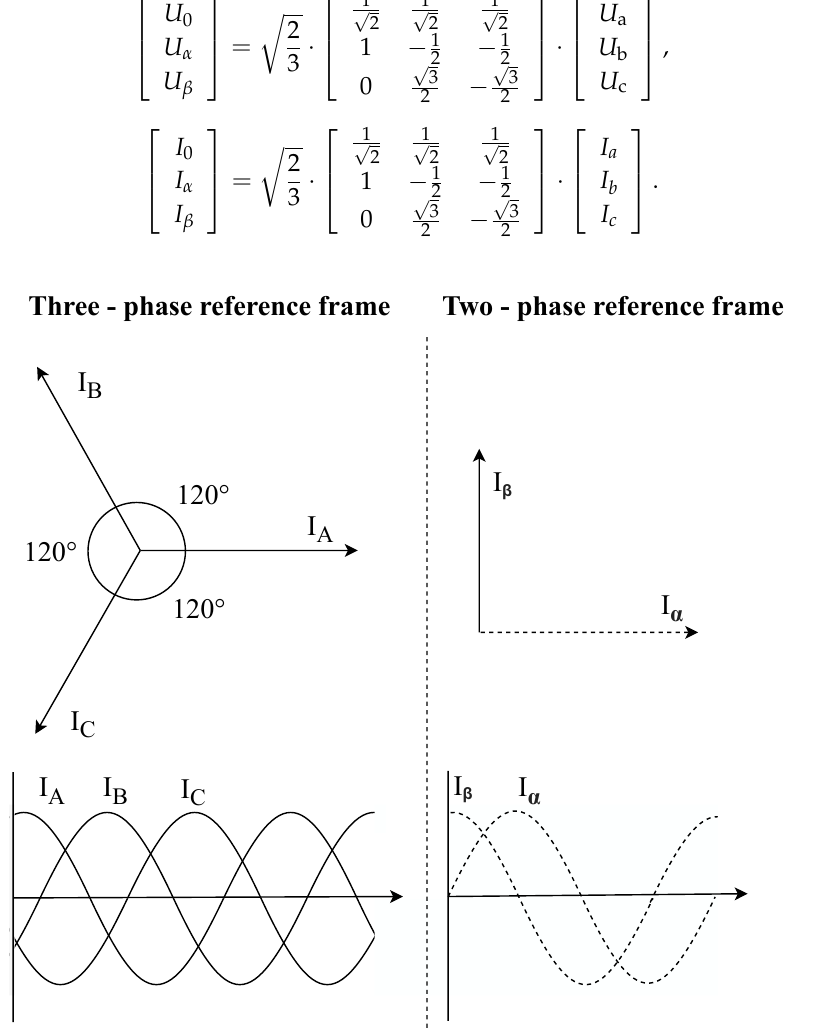
Figure 2. Clarke transformation